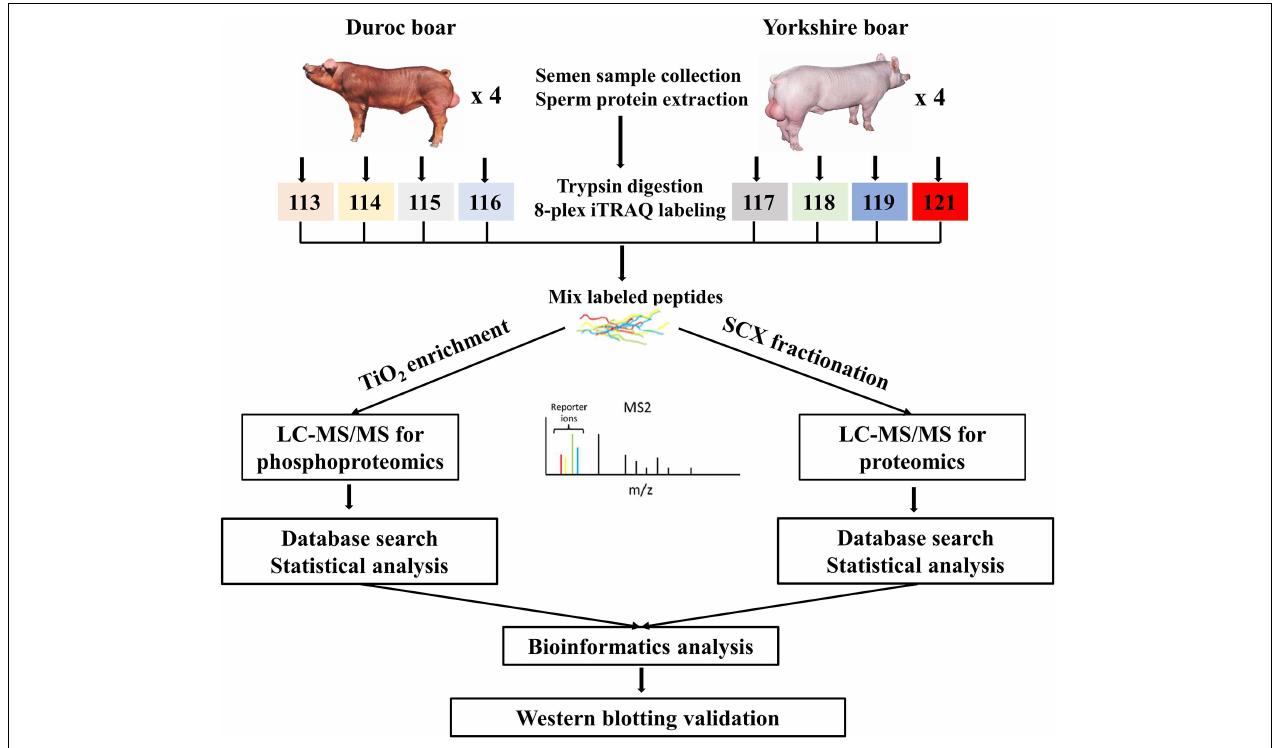
FIGURE 1 | Experimental design and schematic diagram of the workflow. Boar sperm was chosen for analysis of the differential proteomes between the Duroc and Yorkshire pig breeds. A total of eight boars were analyzed by iTRAQ 8Plex-based parallel quantitative proteomics and phosphoproteomics, using the LC-MS/MS workflow. After thorough statistical analyses of the proteomics data, the differentially expressed proteins and phosphoproteins/sites were conducted for the subsequent bioinformatics analysis and some of the important differentially expressed proteins were selected for validation of the discovery results by western